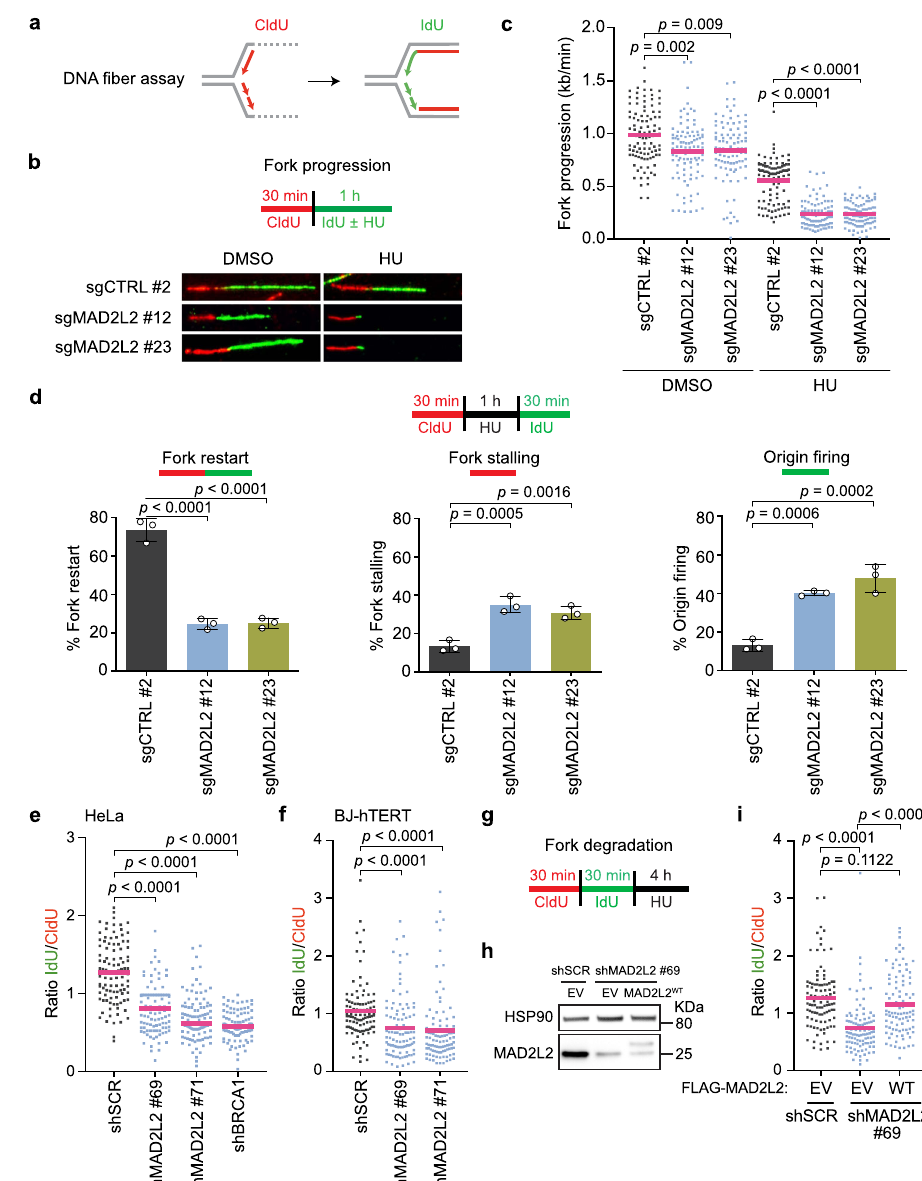
Fig. 2 | MAD2L2 mediates protection and recovery of stalled replication forks. a Schematic of the DNA fi ber assay, in which ongoing replication forks are sequentially labeled with two nucleotide analogues (CldU and IdU). b Top panel: schematic of fork progression assays. Cells were labeled with CldU (red) followed bytreatmentwithorwithout4mMHUduringtheIdU(green)labelingperiod(1h). Bottom panel: representative DNA fi bers in control (sgCTRL) and MAD2L2- depleted HeLa cells. c Quanti fi cation of fork progression. Data was calculated by dividing tractlengths ofIdU by the labeling time (kb/min). d Top panel:schematic of fork restart assays. Tract lengths of CldU and IdU were measured in control (sgCTRL) and MAD2L2-depleted HeLa cells upon HU release to assess fork restart, fork stalling and origin fi ring. Quanti fi cation is shown below. Bars represent the mean±SD. Each dot represents one of three independent experi- ments. e, f, g Quanti fi cation ( e, f ) and schematic ( g ) of fork degradation assays. Cells were labeled with CldU followed by IdU and then treated with 4mM HU to